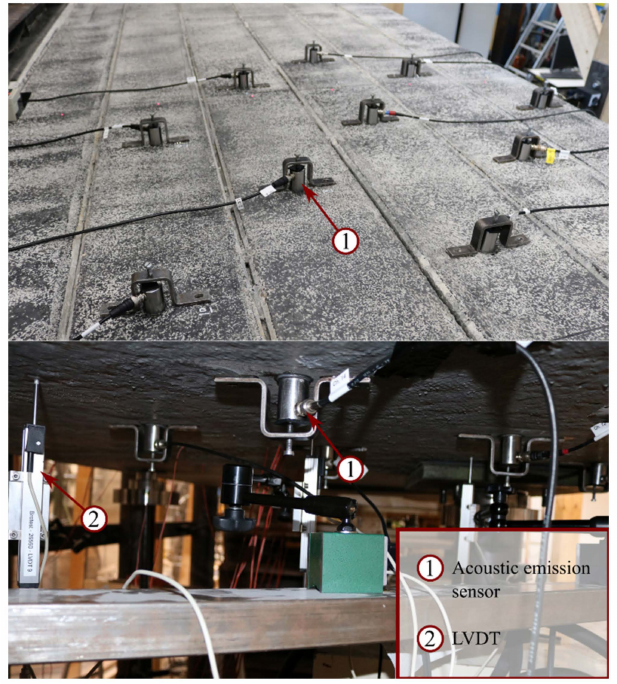
Figure 6. AE sensors mounted on top and bottom surfaces and LVDTs on the bottom surface.